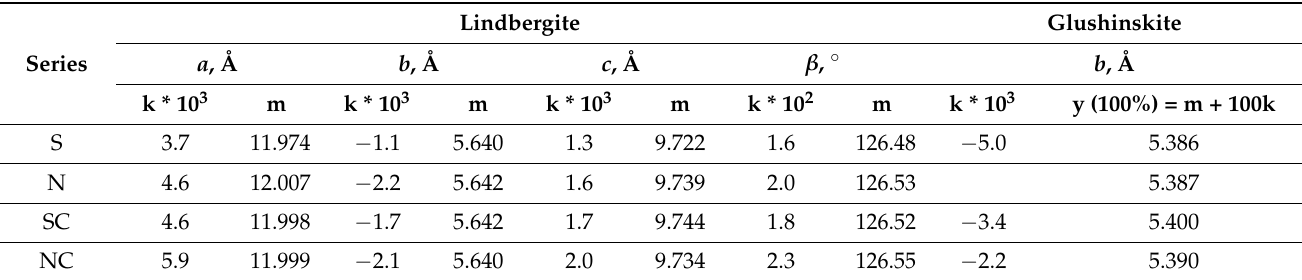
Table 2. Coefficients of regression equations y = m + kx with x = Mg/(Mg + Mn) % in solution, y—one of unit cell